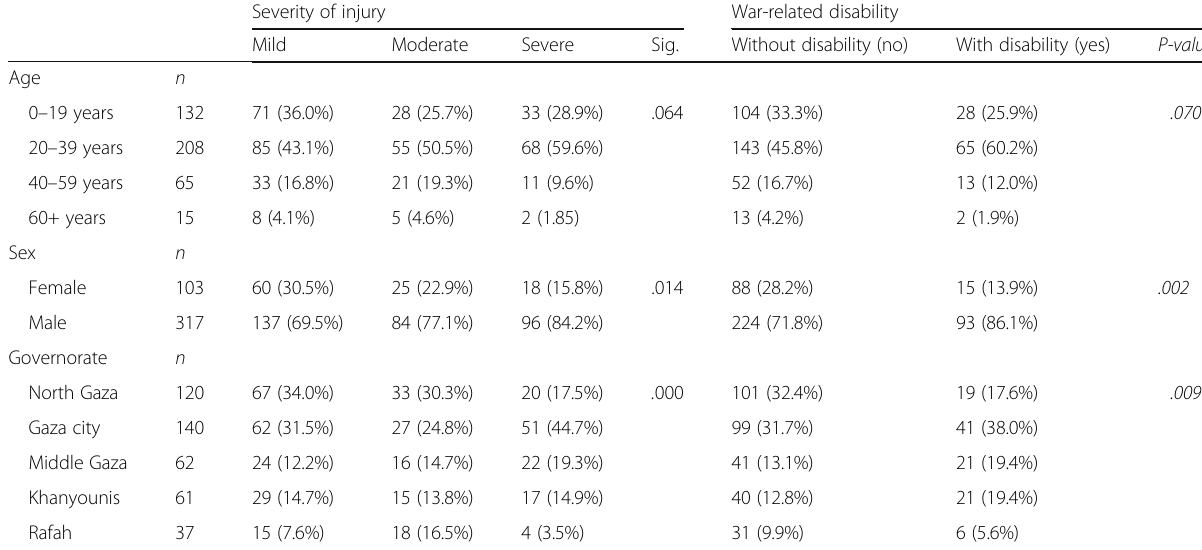
Table 5 Severity and war-related disability according to age, sex, and residence Severity of